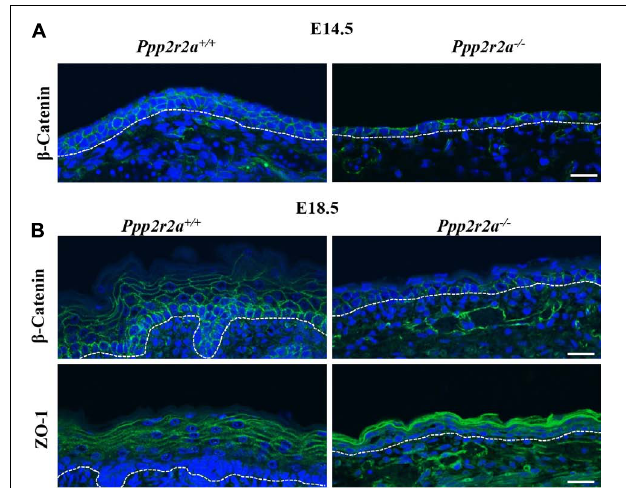
FIGURE 7 | Aberrant cell-cell junctions in the Ppp2r2a knockout epidermis. (A) Representative immunofluorescent pictures of β -Catenin (green) labeling at E14.5 in Ppp2r2a + / + and Ppp2r2a − / − epidermis. DAPI is shown in blue. (B) Representative immunofluorescent pictures of β -Catenin (green) and ZO-1 (green) in E18.5 Ppp2r2a + / + and Ppp2r2a − / − epidermis. DAPI is shown in blue. Dashed white line indicates the dermal-epidermal junction. All scale bars = 25 µ